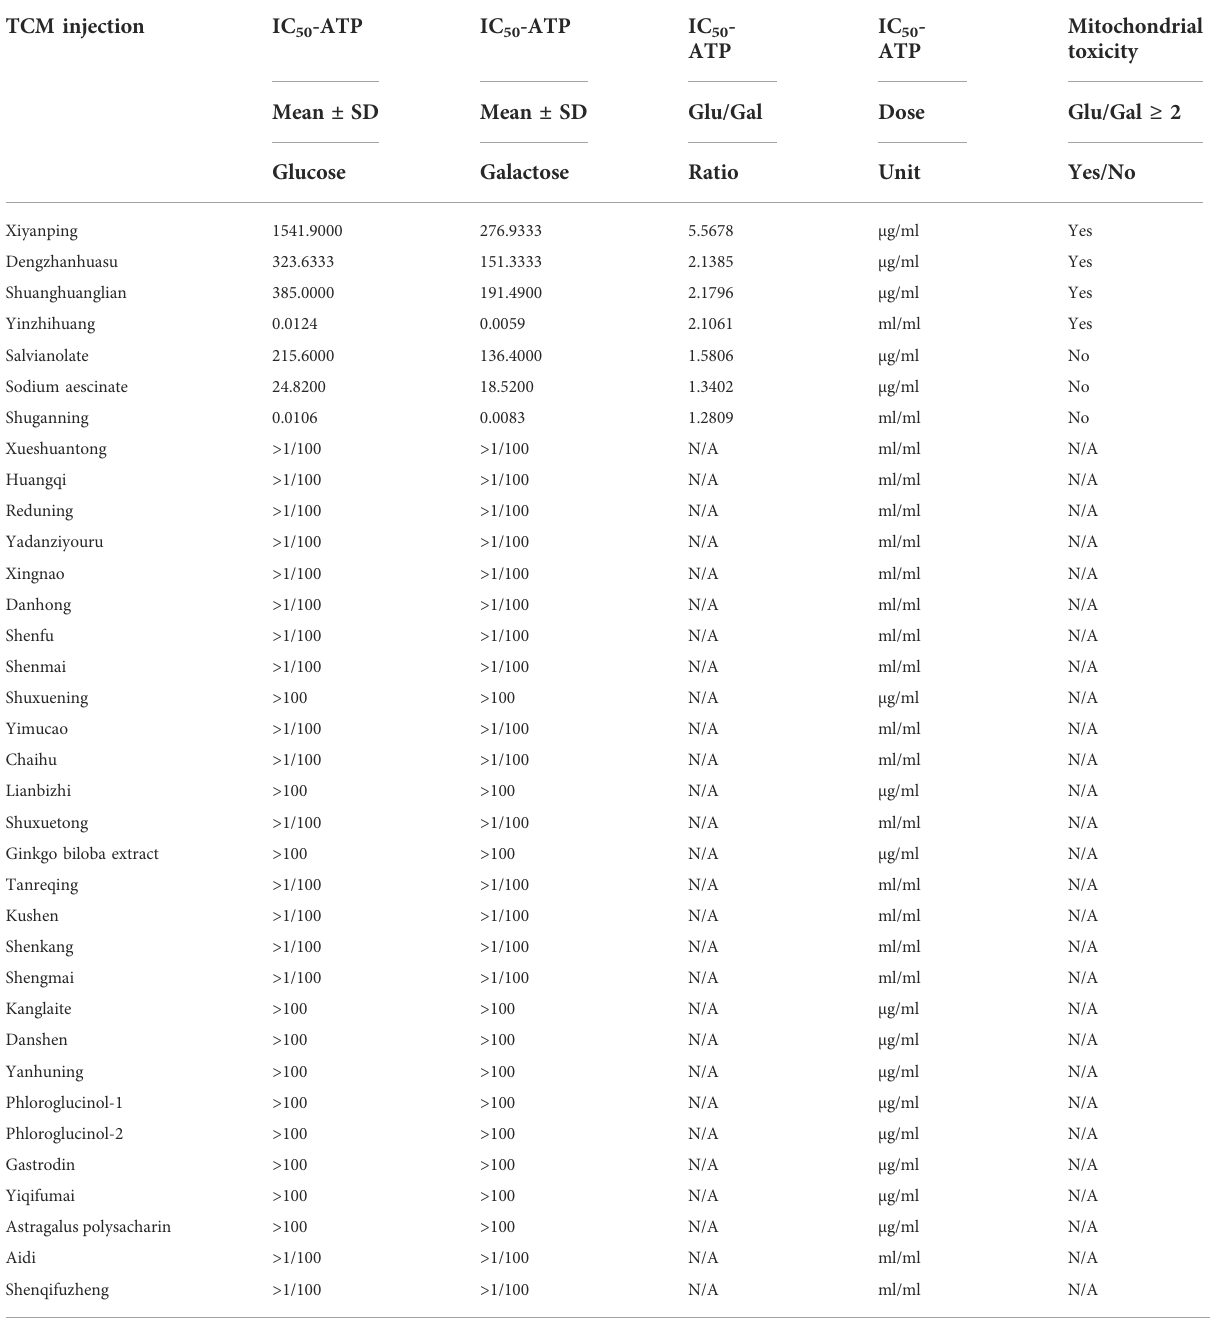
TABLE 1 The effect of TCM injections exposure on ATP depletion in HepG2 cells. TCM